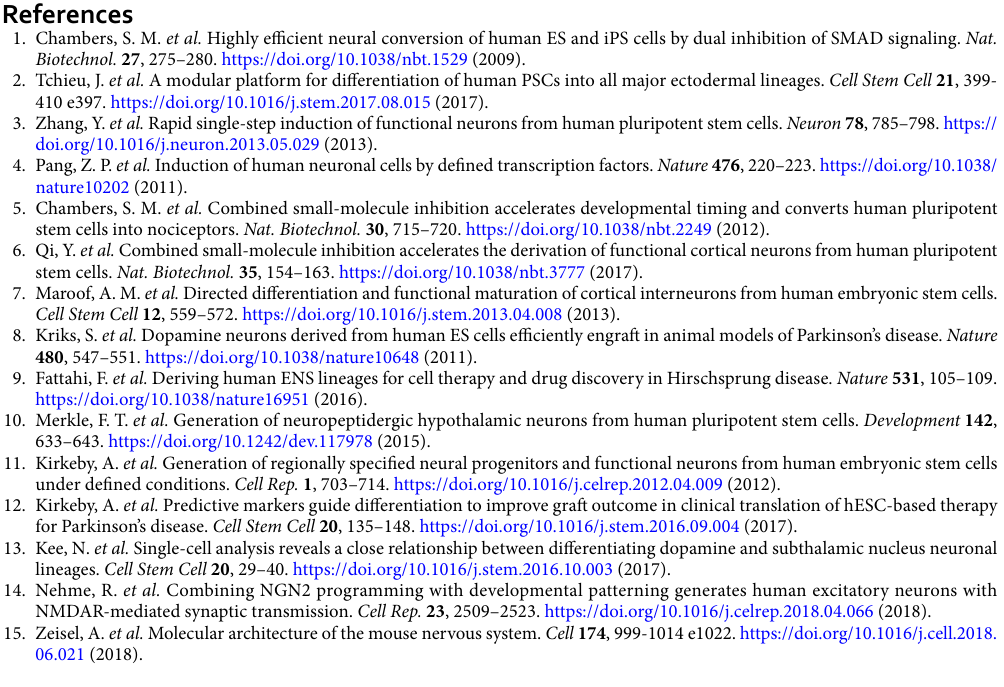
Table 2. Relative gene expression normalized GAPDH, or Relative Gene Expression (GAPDH), was calculated − d Ct from the 2 , where d Ct = Target gene Ct − GAPDH Ct . Immunofluorescence microscopy. PBS + 2%FBS for 30 min. Primary antibody stain was performed 4°C ON (1:400 TH Rb Calbiochem 657012; 1:1000 BIII tubulin Ms Biolegend 801201). Next day, cells were washed with 0.1% Saponin PBS + 2%FBS and stained with secondary antibodies (1:500 Donkey anti Rb 488 Invitrogen A-21206; 1:500 Donkey anti Ms 647 Invitrogen A-31571) for 30 min room temperature. Cells were washed, mounted with Prolong Diamond Anti- fade Mountant (Invitrogen), and imaged with Leica DMI4000B confocal microscope with Leica Application Suite X. CRISPR/Cas9 gene editing. For TH reporter engineering, TH-guide1 and TH-guide2 were cloned into PX461 (Addgene 48140). 2131 iPSC line was plated at 70,000 cells/cm 2 in mTeSR1 + Y on